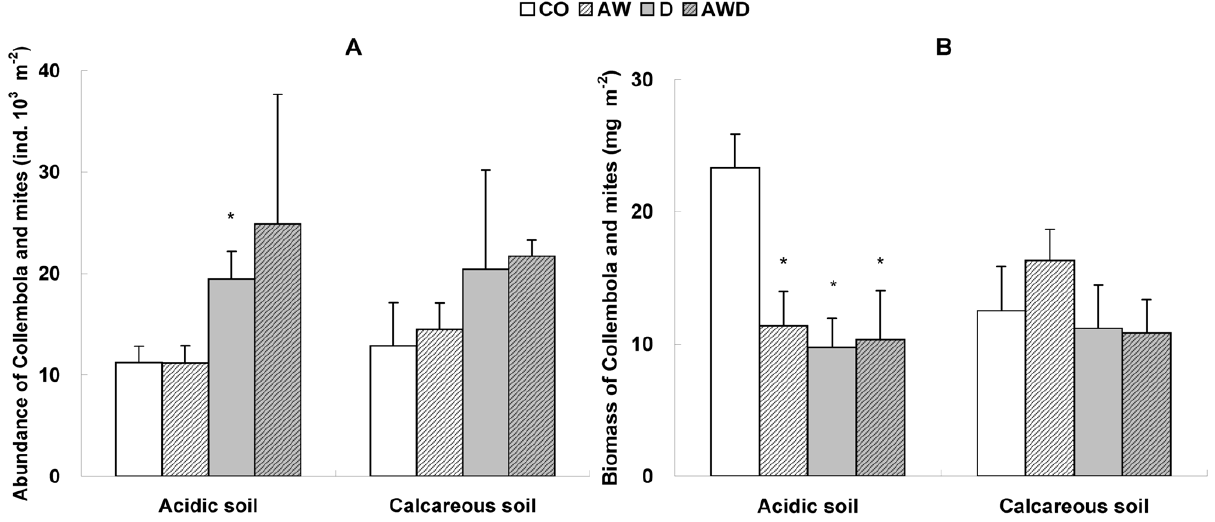
Figure 4. Effects of climate treatments and soil types on the community of Collembola and mites. Effects of the treatments (CO=control, AW=air warming, D=drought, AWD=drought + air warming) on (A) the abundance of Collembola and mites (ind. 10 3 m 2 2 ) and (B) the biomass of Collembola and mites (mg m 2 2 ) in two forest soils (acidic and calcareous), with mean values + SE, where * indicates significant differences from CO ( P , 0.05, n=3).